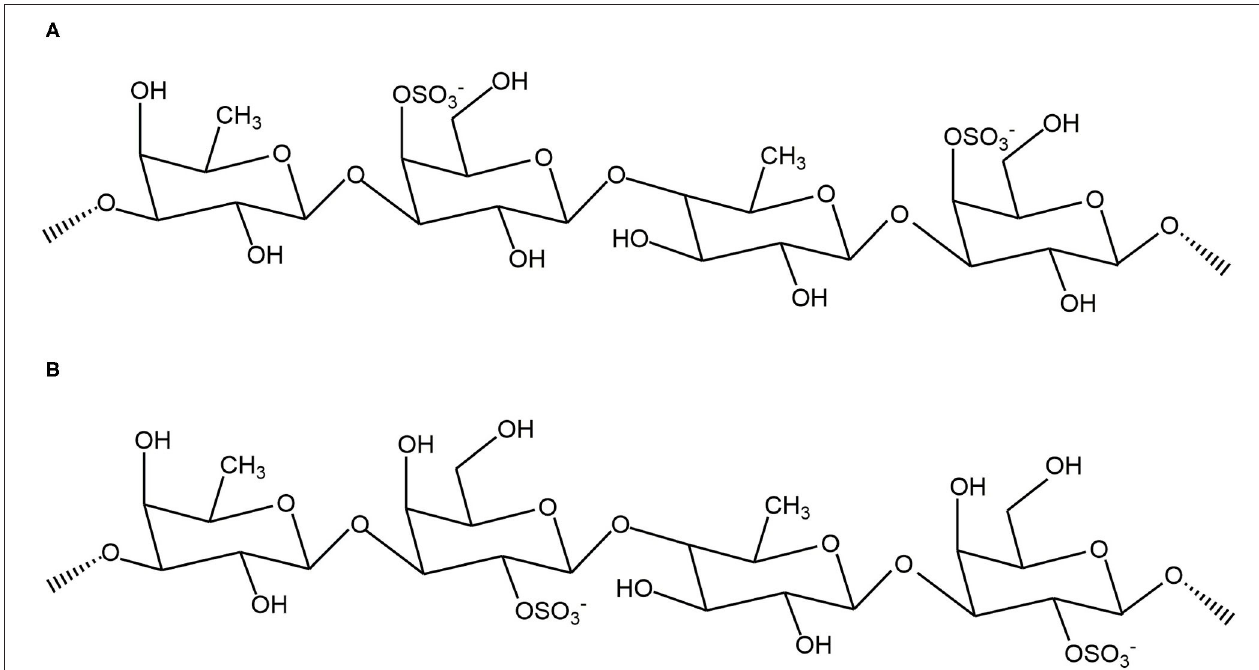
FIGURE 5 | Proposed backbone structures of fucoidan crude extract with panel (A) showing C4 sulfation and panel (B) showing C2 sulfation.